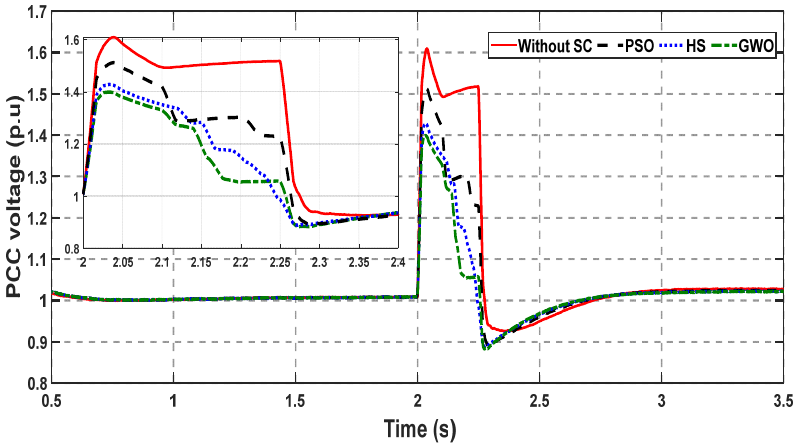
Figure 6. PCC voltage during the voltage swell case study.